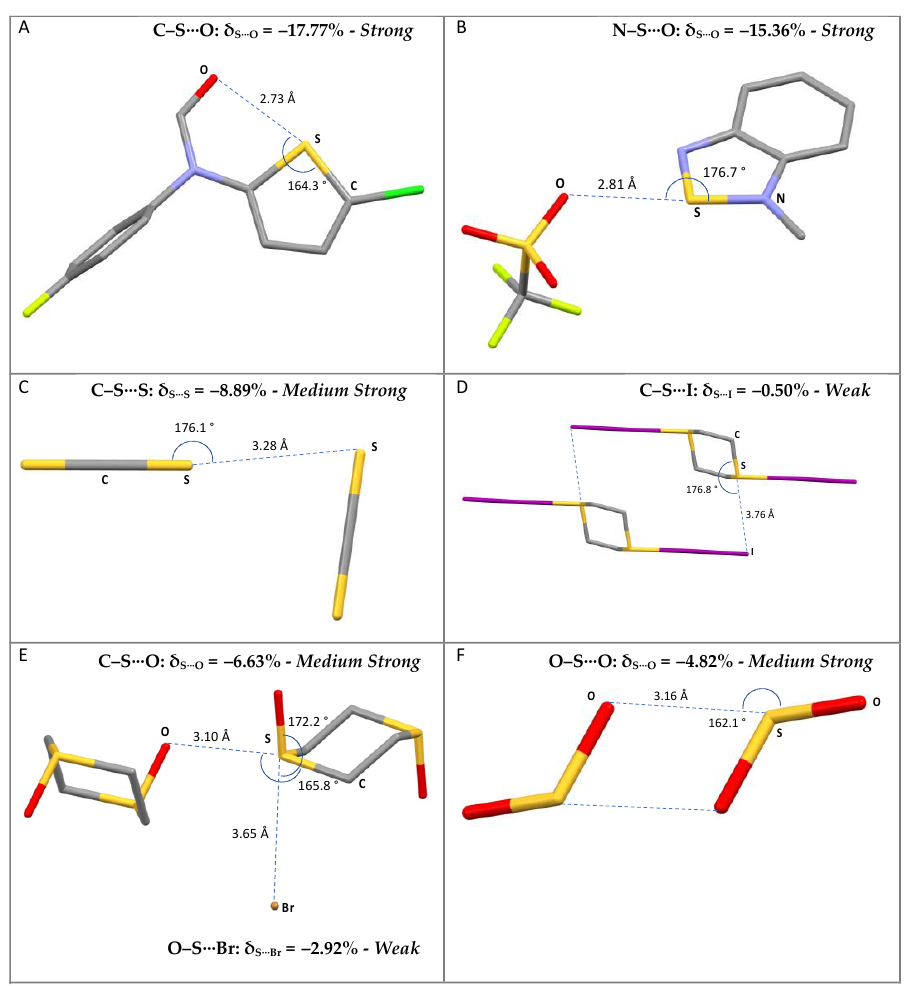
Figure 1. Examples of selected R–S · · · A fragments featuring a chalcogen bond and corresponding CCDC refcodes: ( A ) TEMWUG; ( B) IFOFUF; ( C) NUVXAF; ( D) MESNOR; ( E ) MESPIN; ( F ) WUQLAY; MW: medium-weak; MS: medium-strong; S: strong. Atom colors: C (gray); N (blue); Oxygen (red); S (yellow); Br (orange); I (purple); Cl (green); F (acid